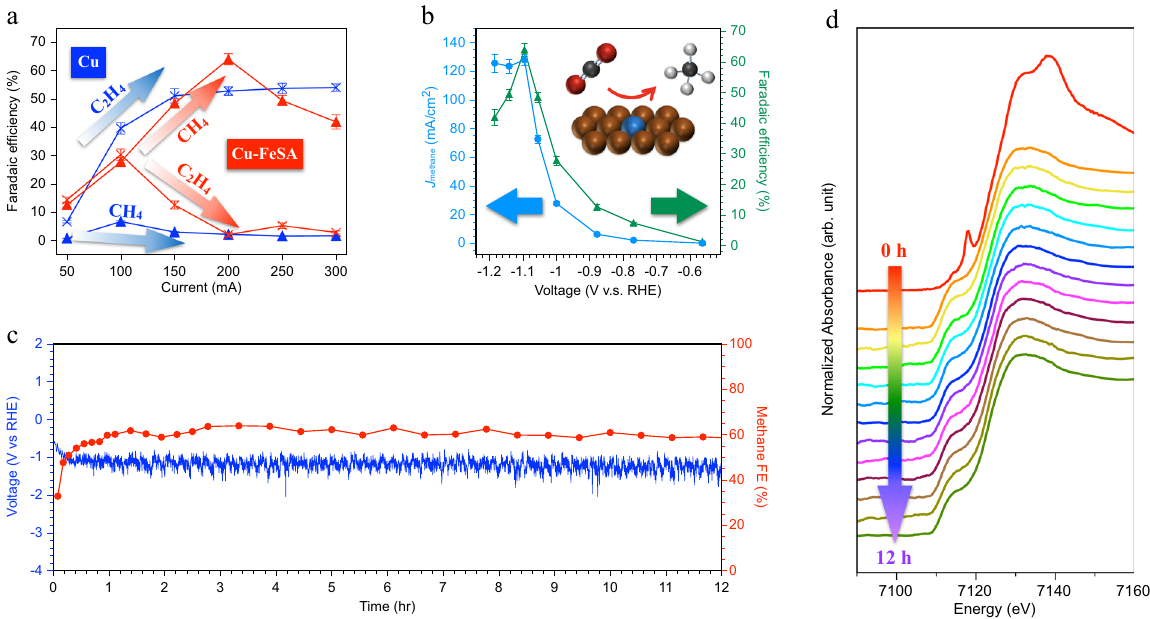
Fig. 4 Catalytic performance of Cu-FeSA. a Comparison of reaction products for pristine Cu and Cu-FeSA. Error bars represent 1 standard deviation on the basis of three independent samples. b Faradaic ef fi ciency and partial current density to methane vs. applied potential. c Stability of methane production. d In-situ X-ray absorption near-edge structure (XANES) of Fe K-edge for long-term investigation over 12 h. The error bars represent 1 s.d. on the basis of three independent